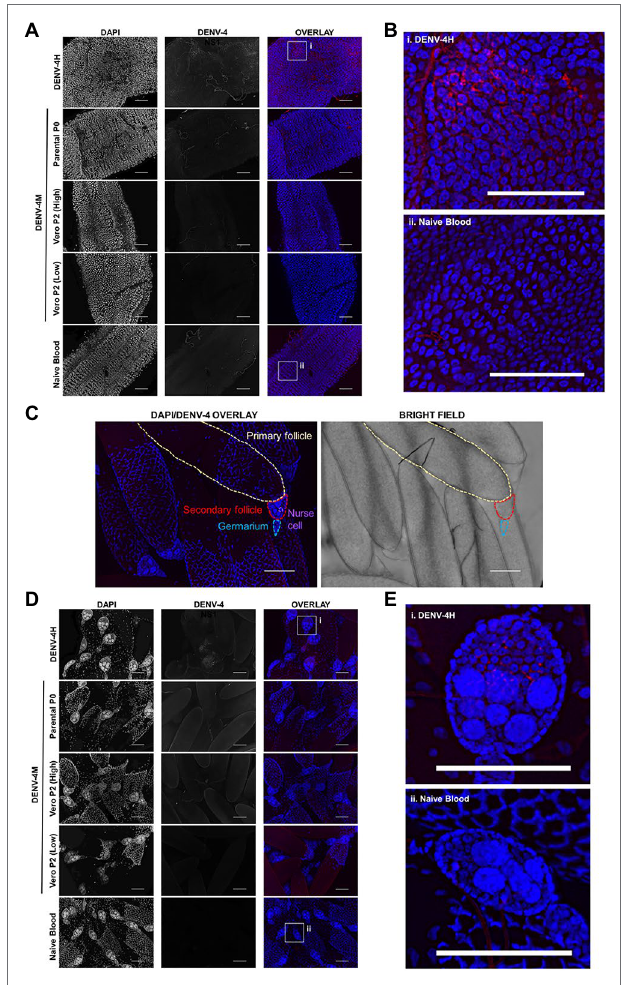
FIGURE 5 | DENV-4H replicates in mosquito midguts and ovaries at 7dpi, but establishment of DENV-4M infection is delayed. Adult female ORL mosquitoes were fed a blood meal containing DENV-4H (5 × 10 6 PFU/ml), Parental P0 DENV-4.M (3 × 10 4 PFU/ml), Vero E6 P2 DENV-4M (high titer: 7 × 10 6 PFU/ml, low titer: 4 × 10 3 PFU/ml), or naive blood without virus. On day 7 post-infection, midguts (A,B) and ovaries (D,E) were dissected, and virus replication was visualized by NS1 IFA (red, middle column) with DAPI DNA counterstain (blue, left column). (C) Shows the major structures of a DENV-4 negative ovariole in DAPI/NS1 IFA and bright field; the primary follicle/ developing embryo, the undeveloped secondary follicle containing nurse cells, and the germarium. (B) and (E) are insets chosen to show NS1 signal in virus positive conditions, compared to the naive blood negative control. Representative images were chosen from at least two independent replicates. Scale bar = 100 μ